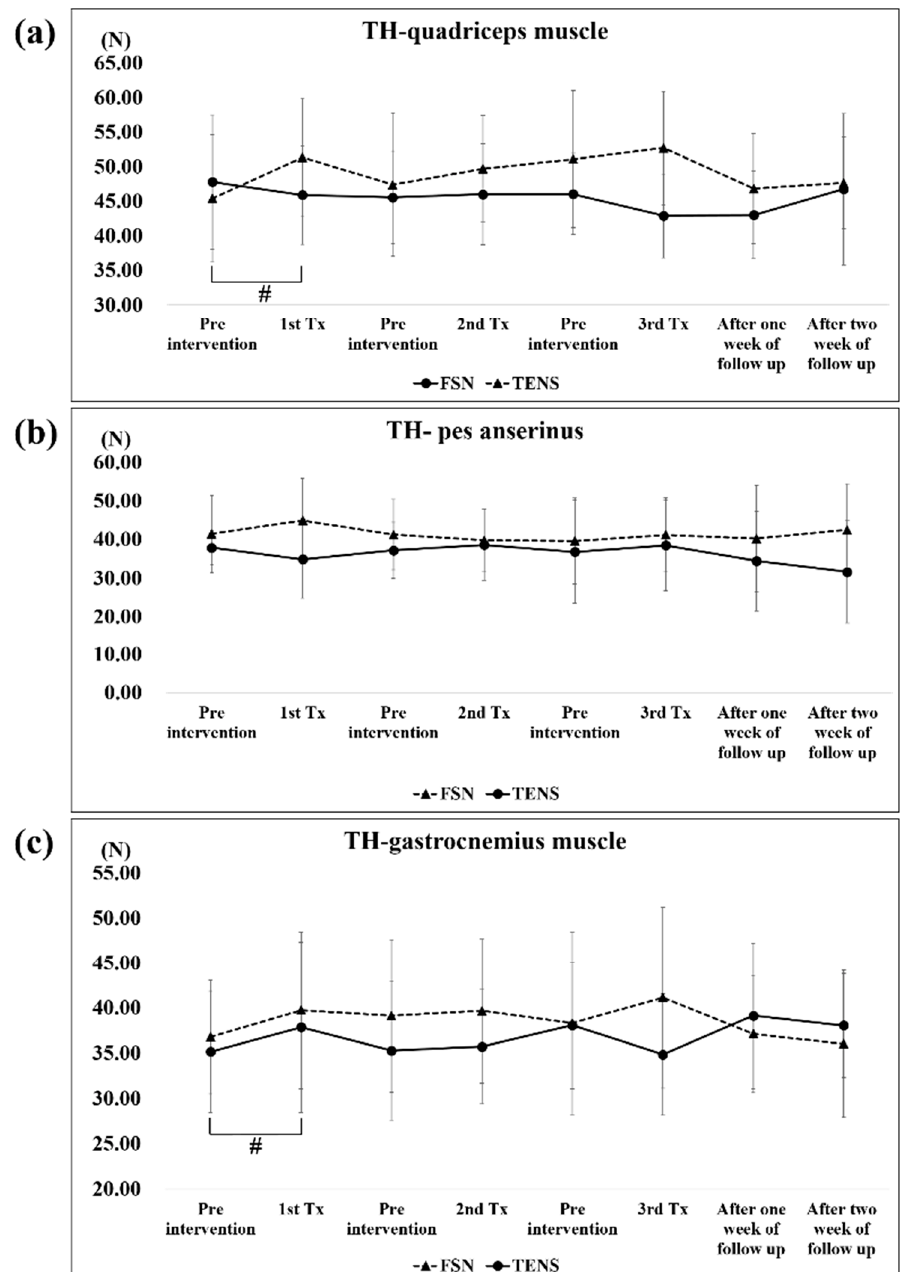
Figure 7. Comparison of TH in the quadriceps muscle ( a ), pes anserinus ( b ), and gastrocnemius muscle ( c ) between the two groups after each treatment. # represents the TENS group p < 0.05. TH: tissue hardness of muscle; FSN: Fu’s subcutaneous needling; TENS: transcutaneous electrical nerve stimulation.